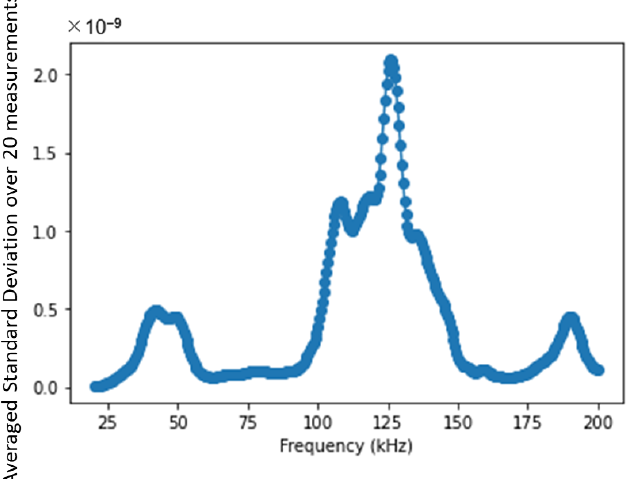
Figure 4. Averaged standard deviation of power intensity at each frequency over 20 measure- ments.